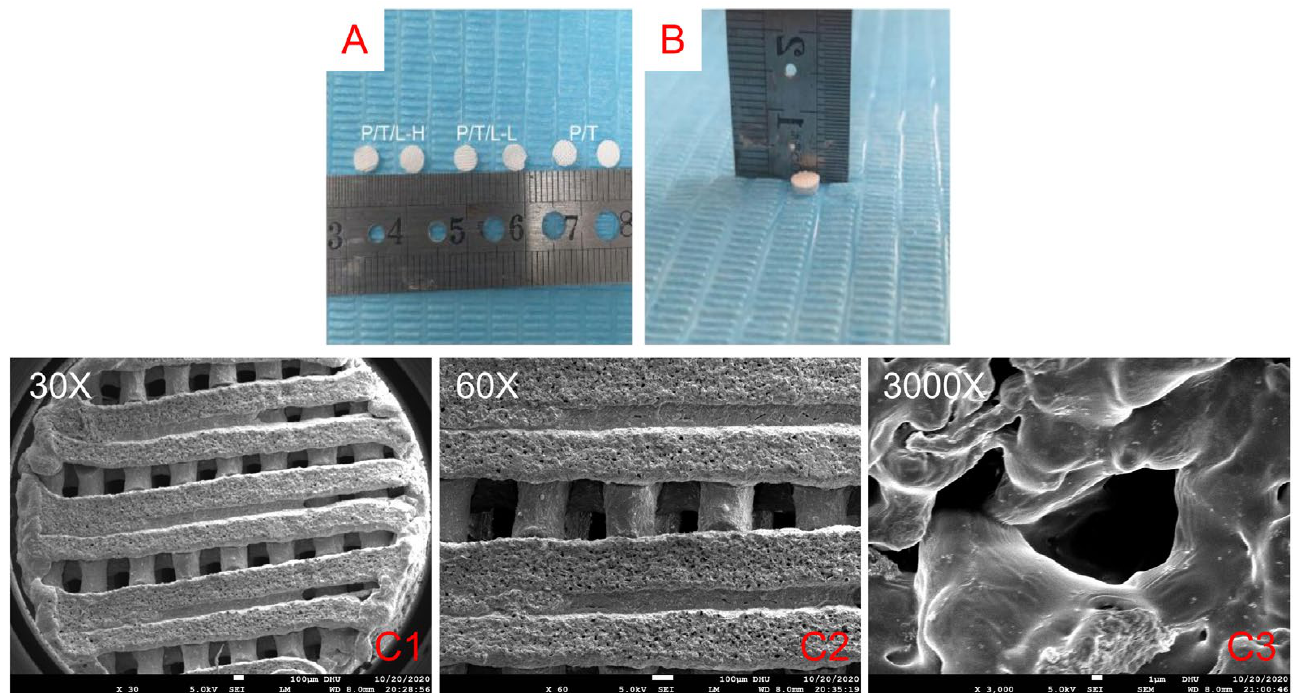
Figure 1. Morphology of the PTL scaffolds. Artificial bone scaffolds prepared by low-temperature 3D printing. The diameters of PTHL, PTLL and PT scaffolds ( A ); the scaffold height of the blank control group ( B ). The PTHL scaffold was magnified 30 times ( C1 ); 60 times ( C2 ); 3000 times ( C3 ) under a scanning electron microscope.